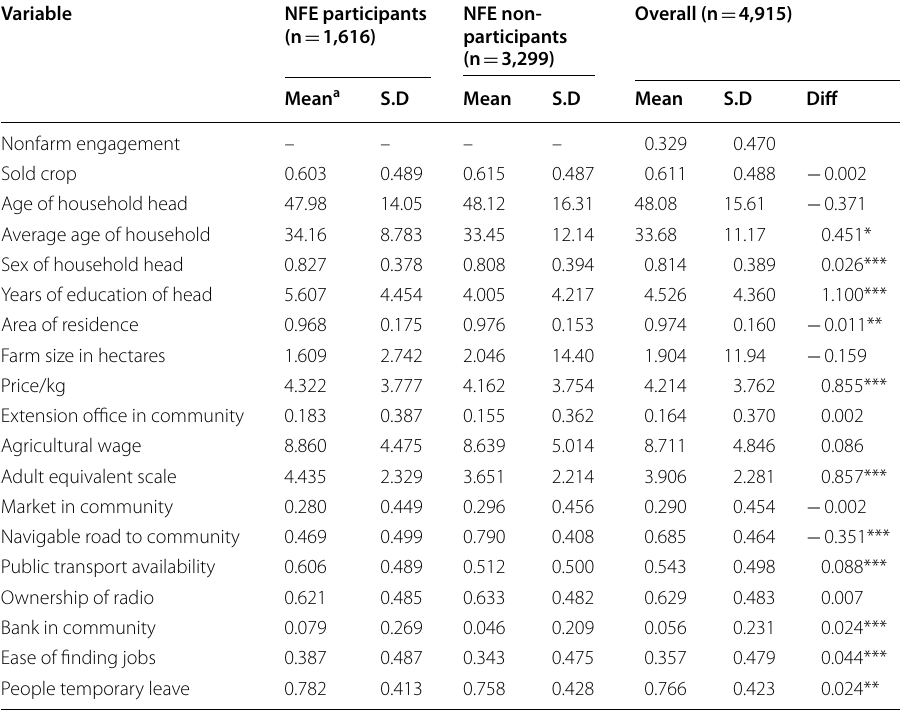
Table 2 Descriptive statistics of variables